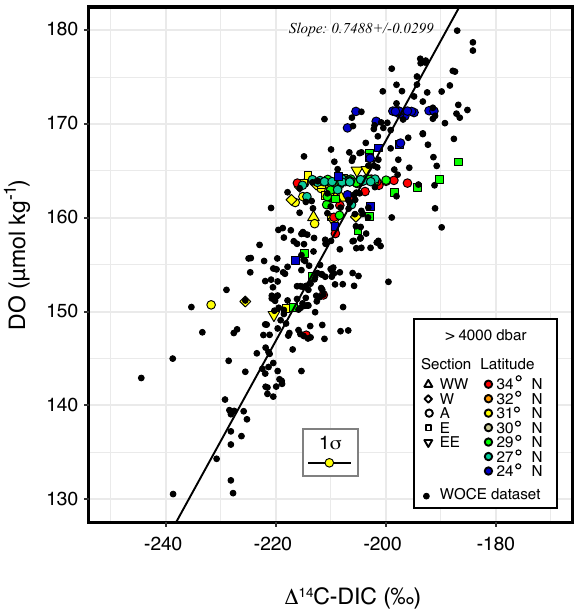
Figure 4. A DO– (cid:49) 14 C plot for deep-sea water (>4000dbar). Col- ored symbols are the same as those in Fig. 2. Filled black circles and the diagonal line, respectively, represent a dataset from WOCE P01-P03 stations and its fitting